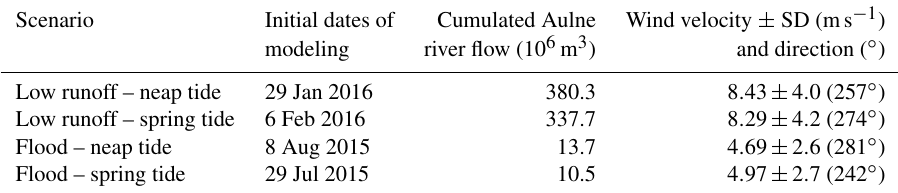
Table 4. Environmental condition for the mean of each computation period over the first 30d of the simulation. Note that SD is the standard deviation.